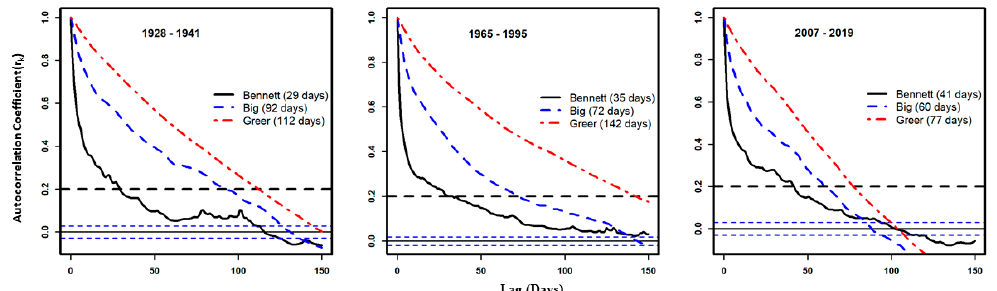
Figure 6. Autocorrelation plots for the studied springs for 1928–1941, 1965–1995, and 2007–2019. The horizontal black dashed line at r k = 0.2 indicates the white noise threshold. The horizontal blue dashed lines represent the statistical significance at 95% of confidence intervals.